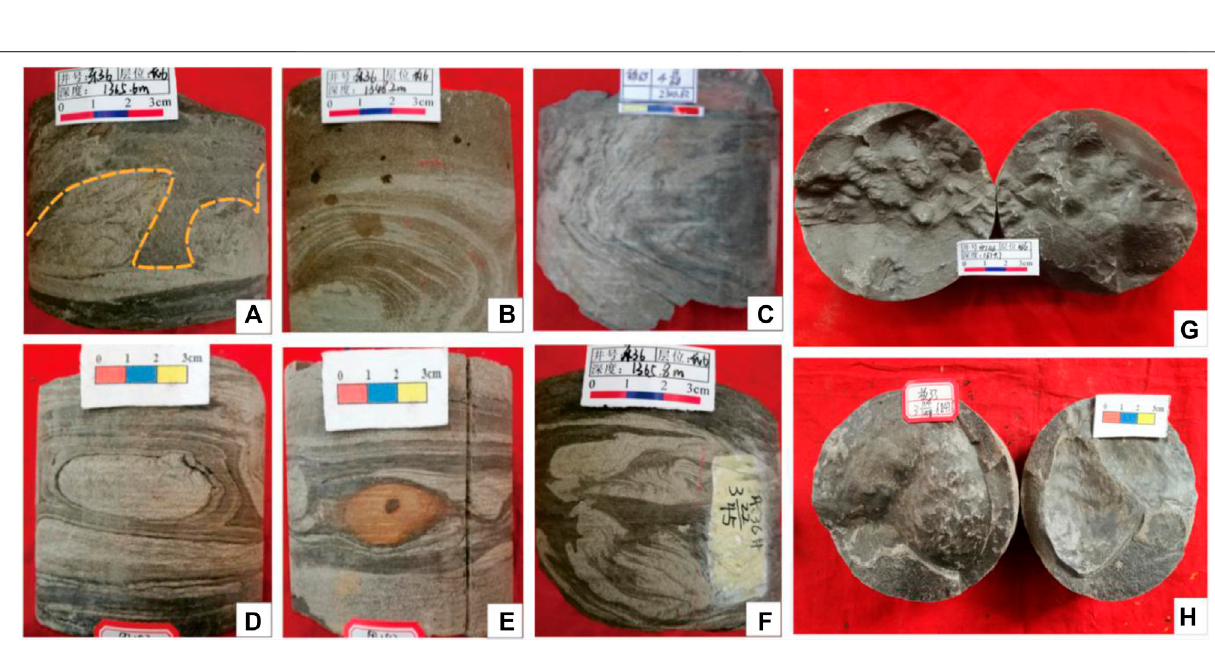
FIGURE 5 | Core depositional characteristics of slide-slump rock on core and outcropping.